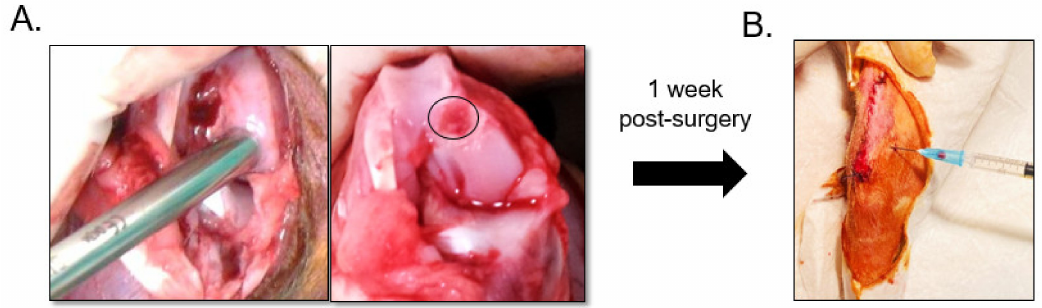
Figure 1. In vivo articular cartilage repair by intraarticular injection of bone-marrow-derived stem/stromal cells (BMSCs) and hyaluronic acid (HA). ( A ) A chondral defect measuring 3 mm in diameter and 1 mm in depth (black circle) was created at the rabbit’s femoral condyle using a trocar. ( B ) Intra-articular injection of BMSCs and HA was performed 1 week